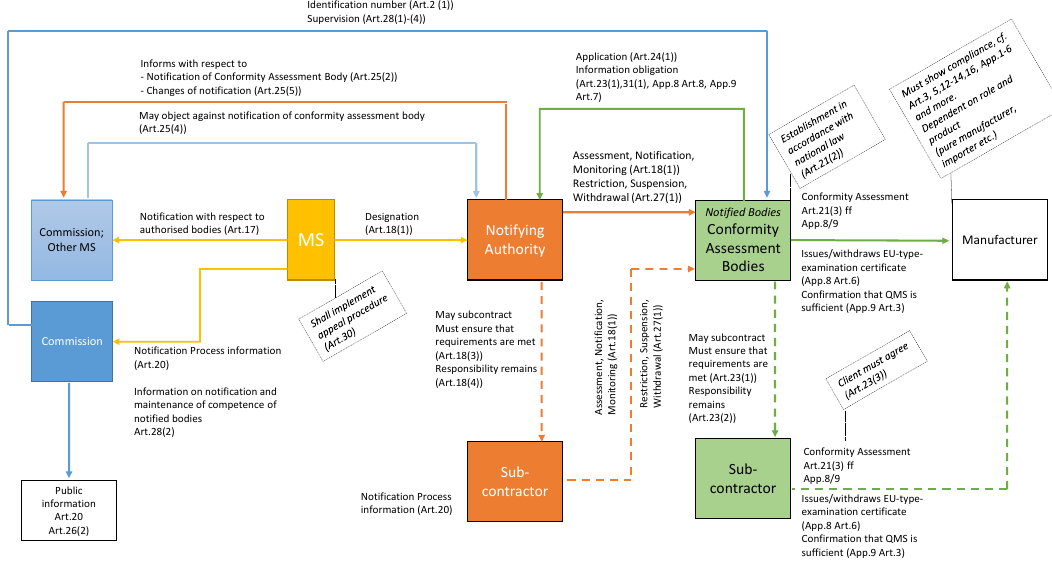
Figure 2. Interaction between stakeholders in accordance with the UAS Market Regulation [6].